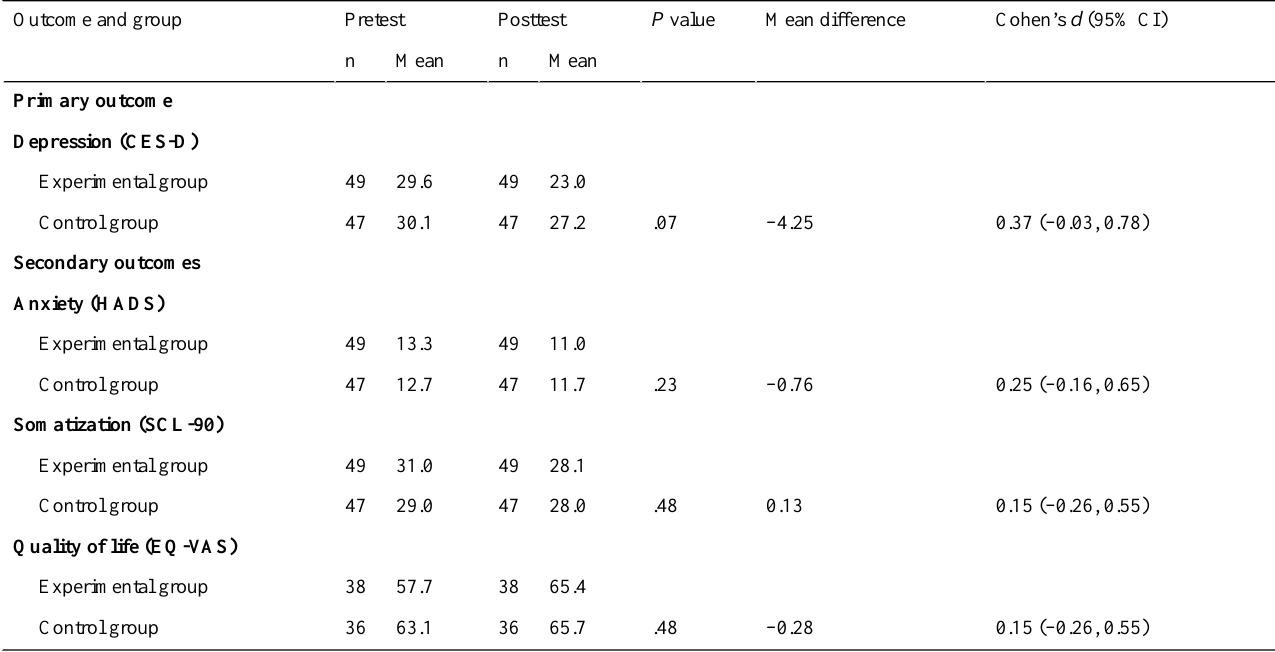
Table 2. Study outcomes at posttest including posttest between-group effect size (Cohen’s d ): intention-to-treat analysis.